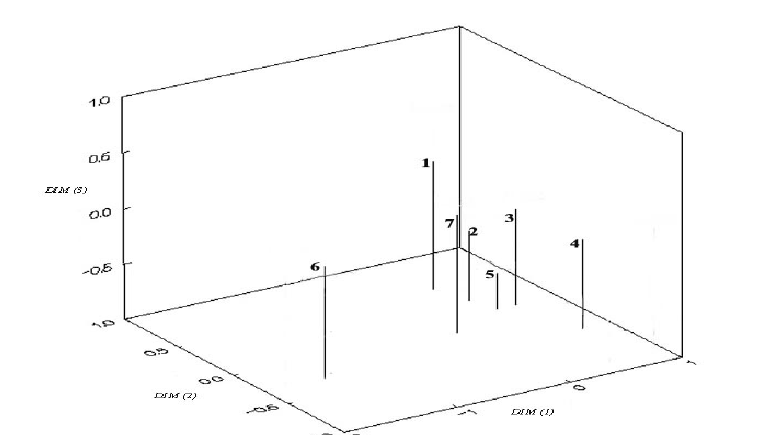
distances showing genetic relationships A